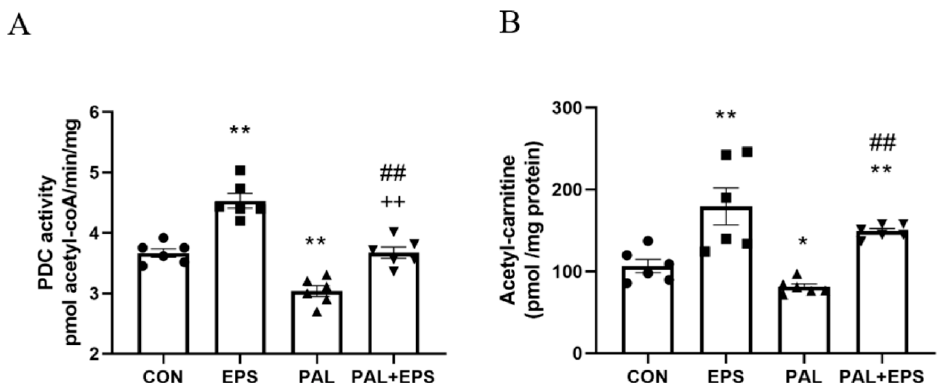
Figure 3. C2C12 myotube pyruvate dehydrogenase complex (PDC) activity ( A ) and acetylcarnitine content ( B ) after exposure to either standard growth media (CON), 16 h of electrical pulse